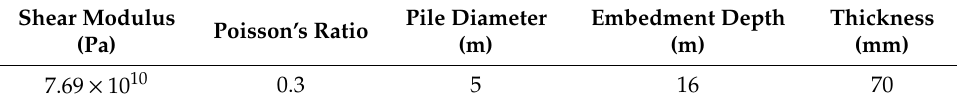
Table 5. Input data of monopile in this